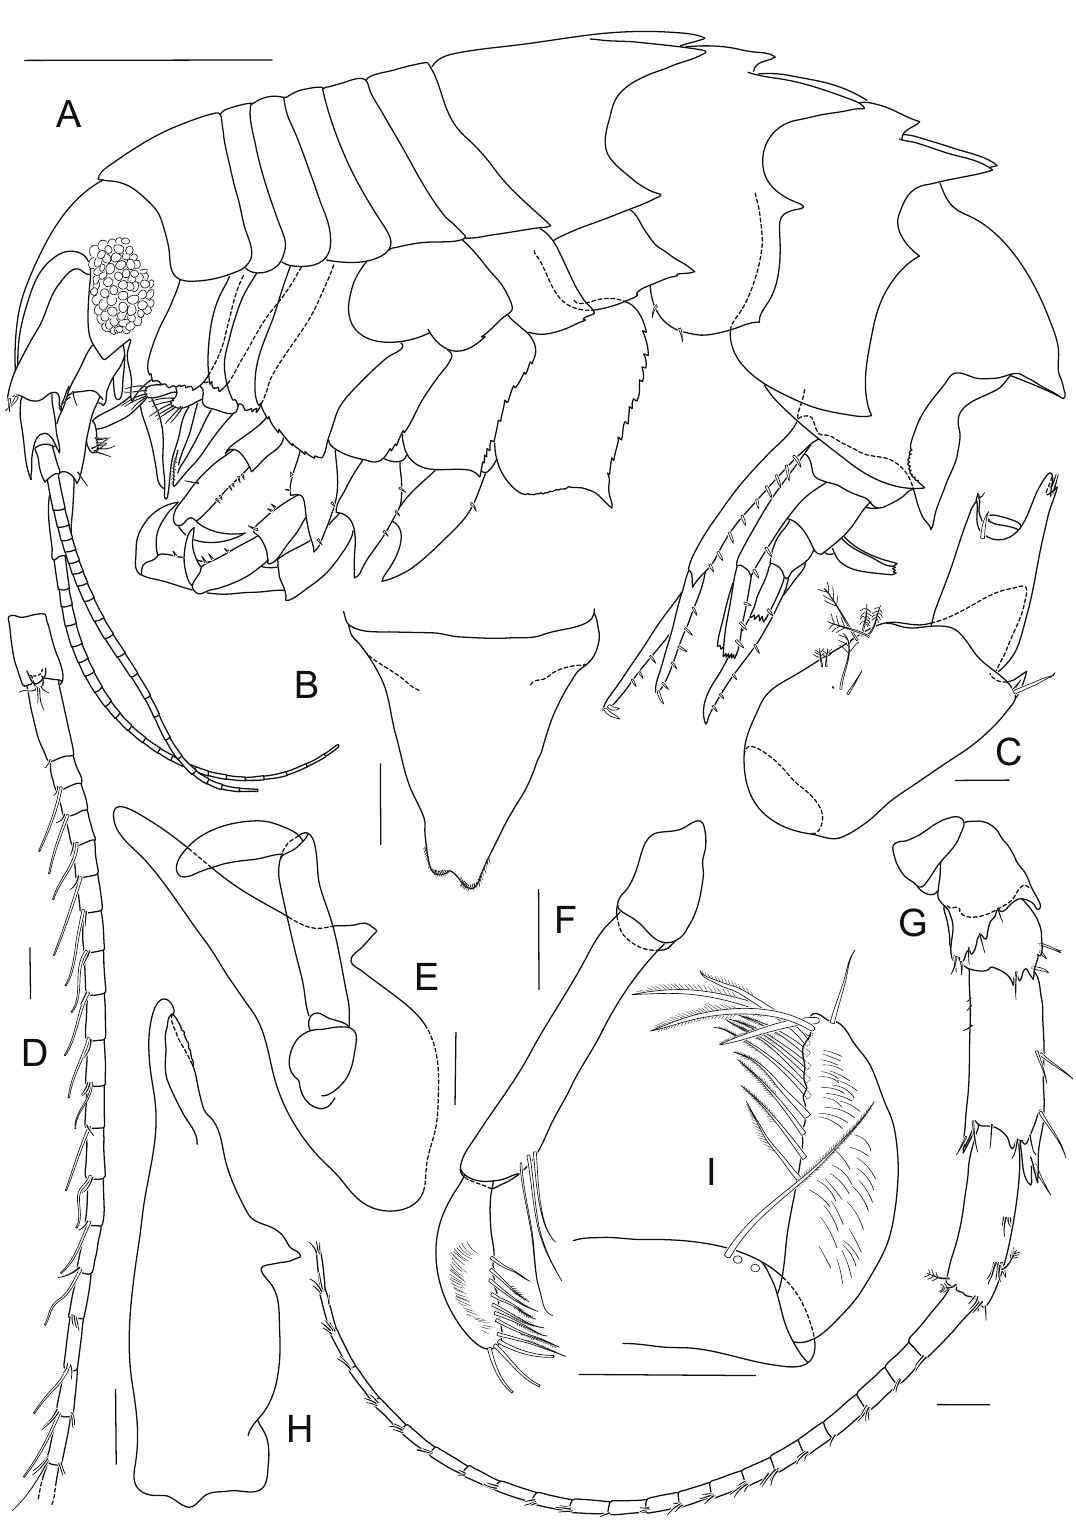
Fig. 7. Labriphimedia martinae nov. sp., holotype ♂, 6.5 mm, NIWA 84743. A . Habitus. B . Upper lip. C . antenna 1 peduncular articles 1-2. D . Peduncular article 3 and flagellum of antenna 1. E . left mandible, setation of palp omitted. F . right mandibular palp. G . antenna 2. H . right mandibular body. I . apical mandibular palp article. Scale bars: a = 1 mm, B-G = 100